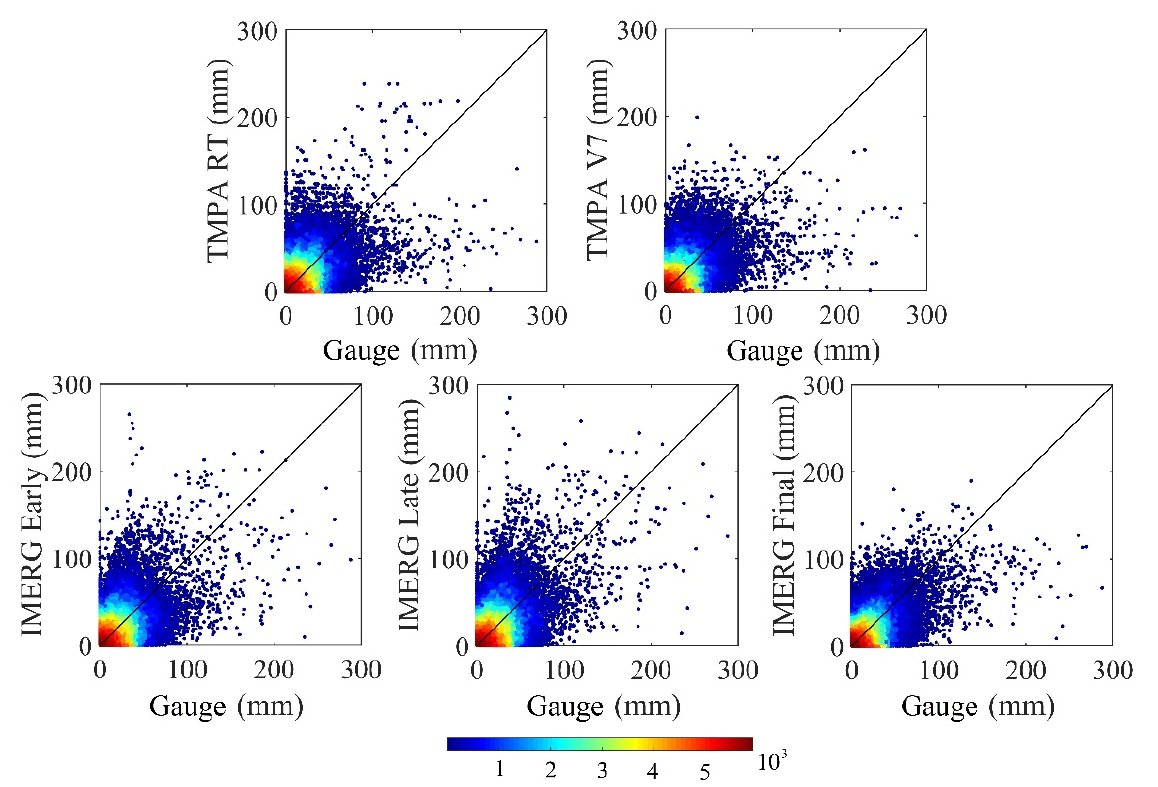
Figure 2. Scatterplots of daily precipitation comparison between five SPPs and rain-gauge observed precipitation. Table 1. Accuracy of the evaluation metrics for the five SPPs in the Mishui